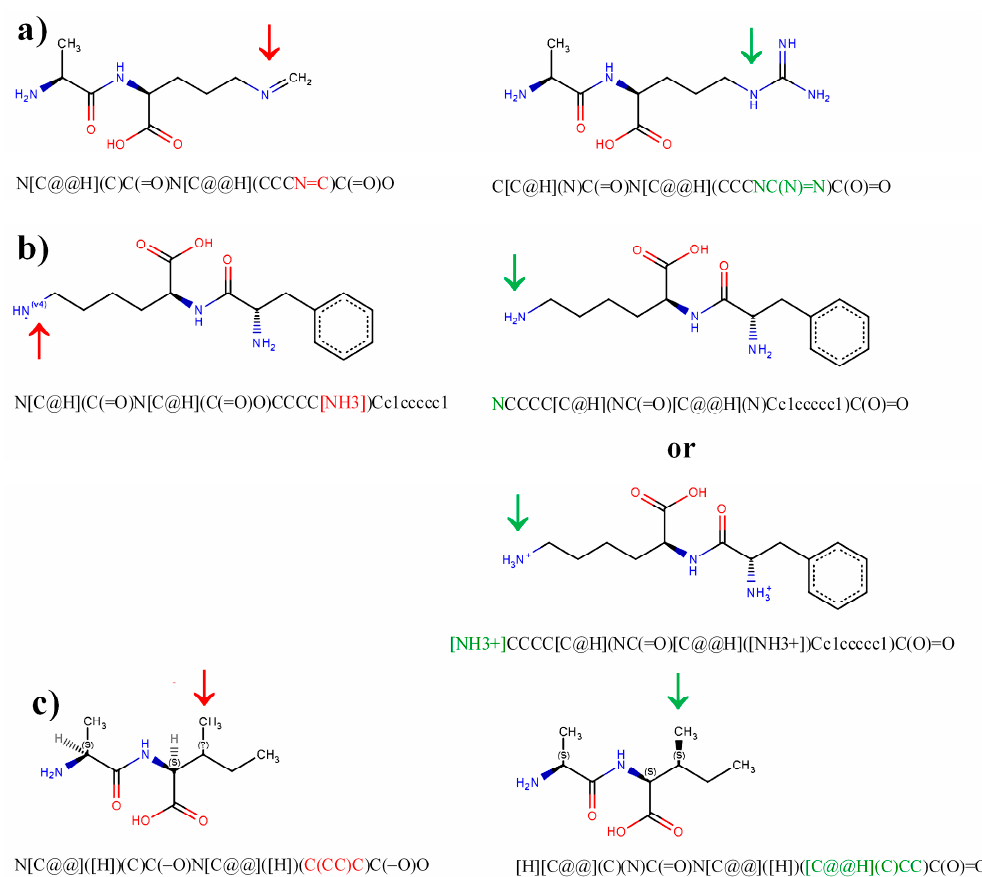
Figure 5. Structures of peptides displayed by molecular editor with errors (left column) and after correction (right column). ( a ) Peptide AR (Ala-Arg) with missed nitrogen atoms in guanidine group; ( b ) peptide FK (Phe-Lys) with inappropriate valence of nitrogen atom in side chain of lysine; ( c ) peptide AI (Ala-Ile) with missed chirality center in Ile residue. Red arrows and red fonts in SMILES representations indicate molecule fragments with errors. Green arrows and green fonts in SMILES representations indicate the same fragments after correction. R—configuration Rectus ; S—configuration Sinister ; ?—undefined configuration of substituents around asymmetric carbon atom. Figure prepared with the help of Marvin JS editor